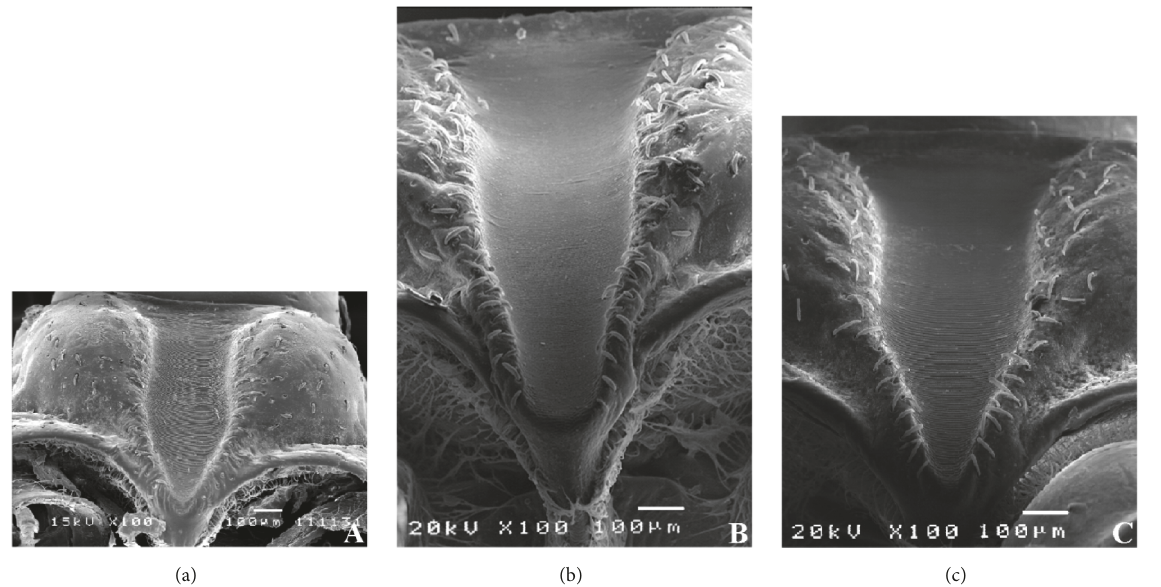
Figure 3: Micrography of the stridulatory sulcus. (a) Triatoma carcavalloi male (V-shaped) . (b) Triatoma circummaculata female (U-shaped). (c) Triatoma rubrovaria male